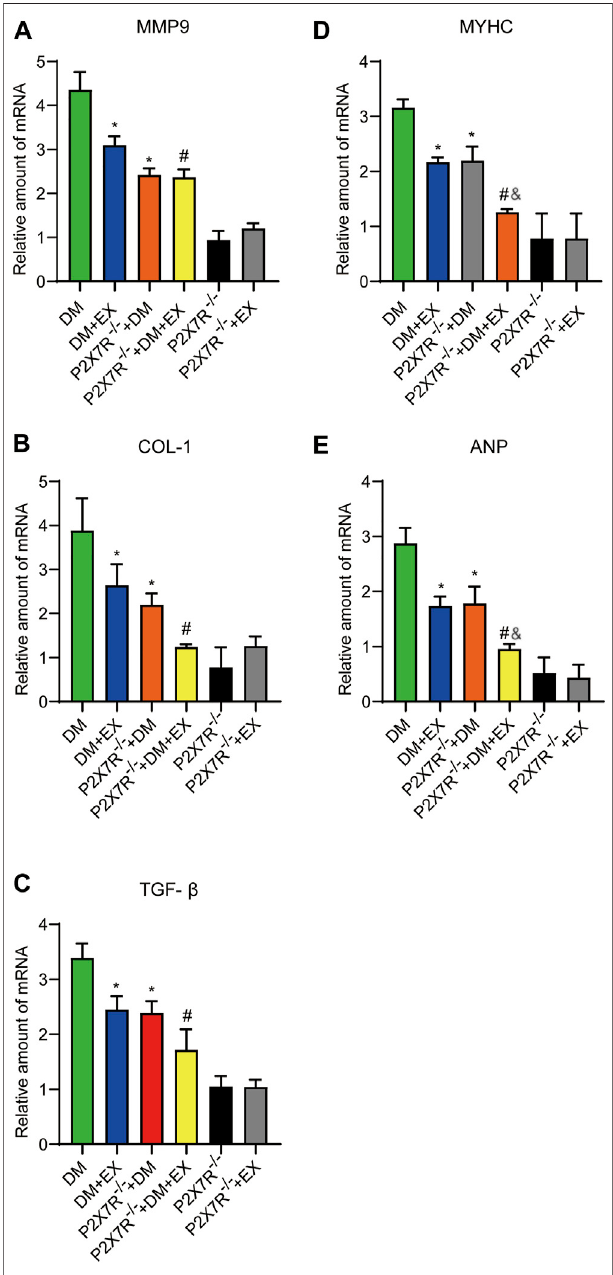
FIGURE10| ThestatisticsofReal-timepolymerasechainreaction(PCR) for fi brosis, hypertrophy and apoptosis indicators. The levels of fi brotic markers (e.g., COL-1, TGF- β , and MMP9) and hypertrophic markers (e.g., MyHCandANP) (A – E) .* p < 0.05vs.theDMgroup, # p < 0.05vs.theDM + EX group. & p < 0.05 vs. the P2X7R − / − + DM group.